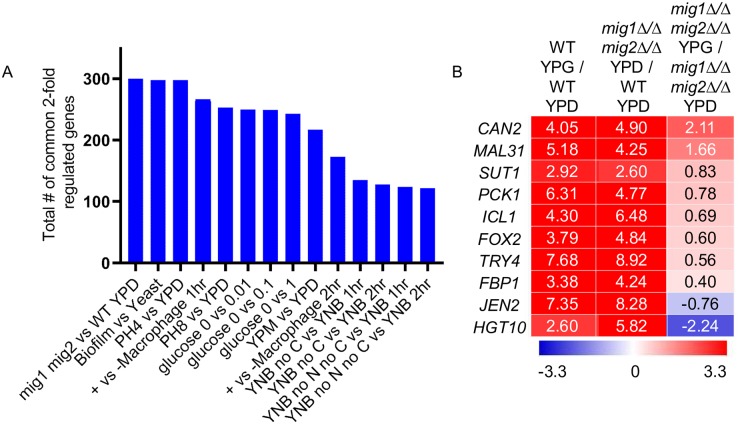
Gene expression dataset comparisons.Comparisons were performed using our genome-wide profiling data of wild-type C. albicans grown in YPG media compared to wild-type grown in YPD media A. Fisher’s Exact Test depicting gene expression datasets most closely related to YPG gene expression. FET was used as previously described [31]. Up- or down-regulated genes with a 2-fold expression change cut-off were matched from 91 published expression datasets (S3 Table). B. Heatmap depicting gene expression of 10 metabolic genes chosen for comparison of glucose-repressed genes. Color scale corresponds to log2 fold change limits of 3.3 up (red) and 3.3 down (blue). Full gene expression datasets are available in S1 Table.